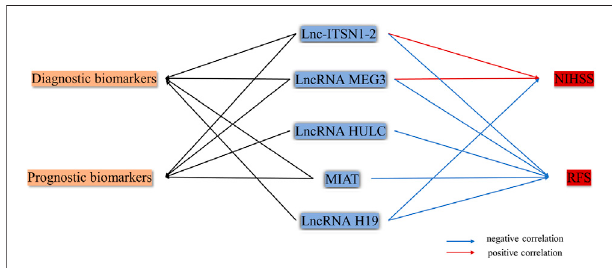
FIGURE 6 | LncRNAs as potential diagnostic and prognostic